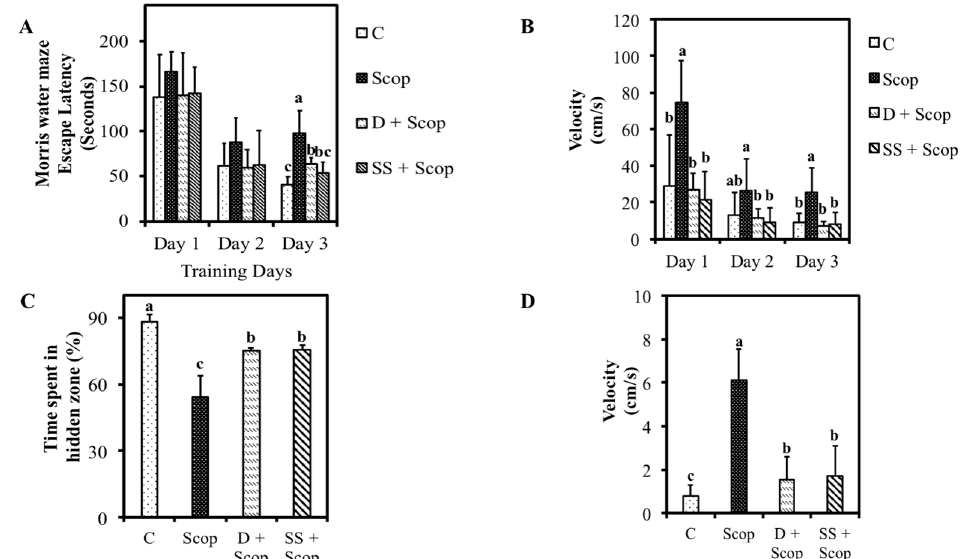
Figure 3. Effect of Stachys sieboldii in scopolamine induced memory impairment was assessed by Morris water maze. SS reduced escape latency ( A ), increased velocity ( B ), time spent in hidden zone during probe trial ( C ) and velocity ( D ) All values are mean ± SD ( n = 10). Mean with different superscripts in the same row indicates significant difference by ANOVA with Tukey’s test at p < 0.05 compared to control group.